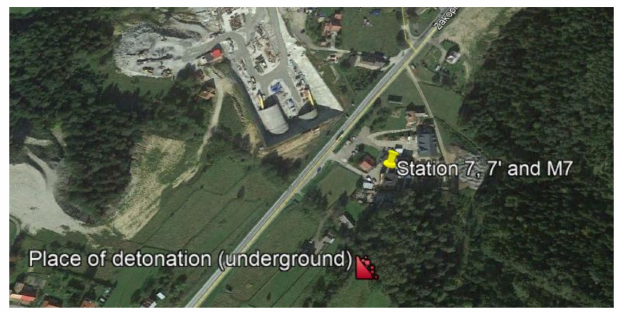
Figure 16. Blasting site and measurement stations.